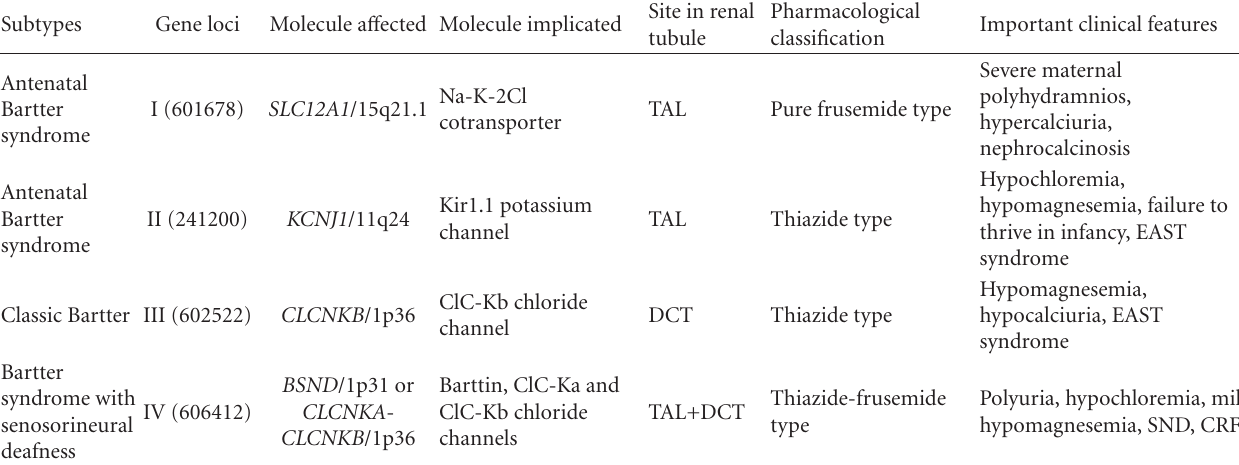
Table 1: Pharmacological classification of Bartter syndrome with important clinical